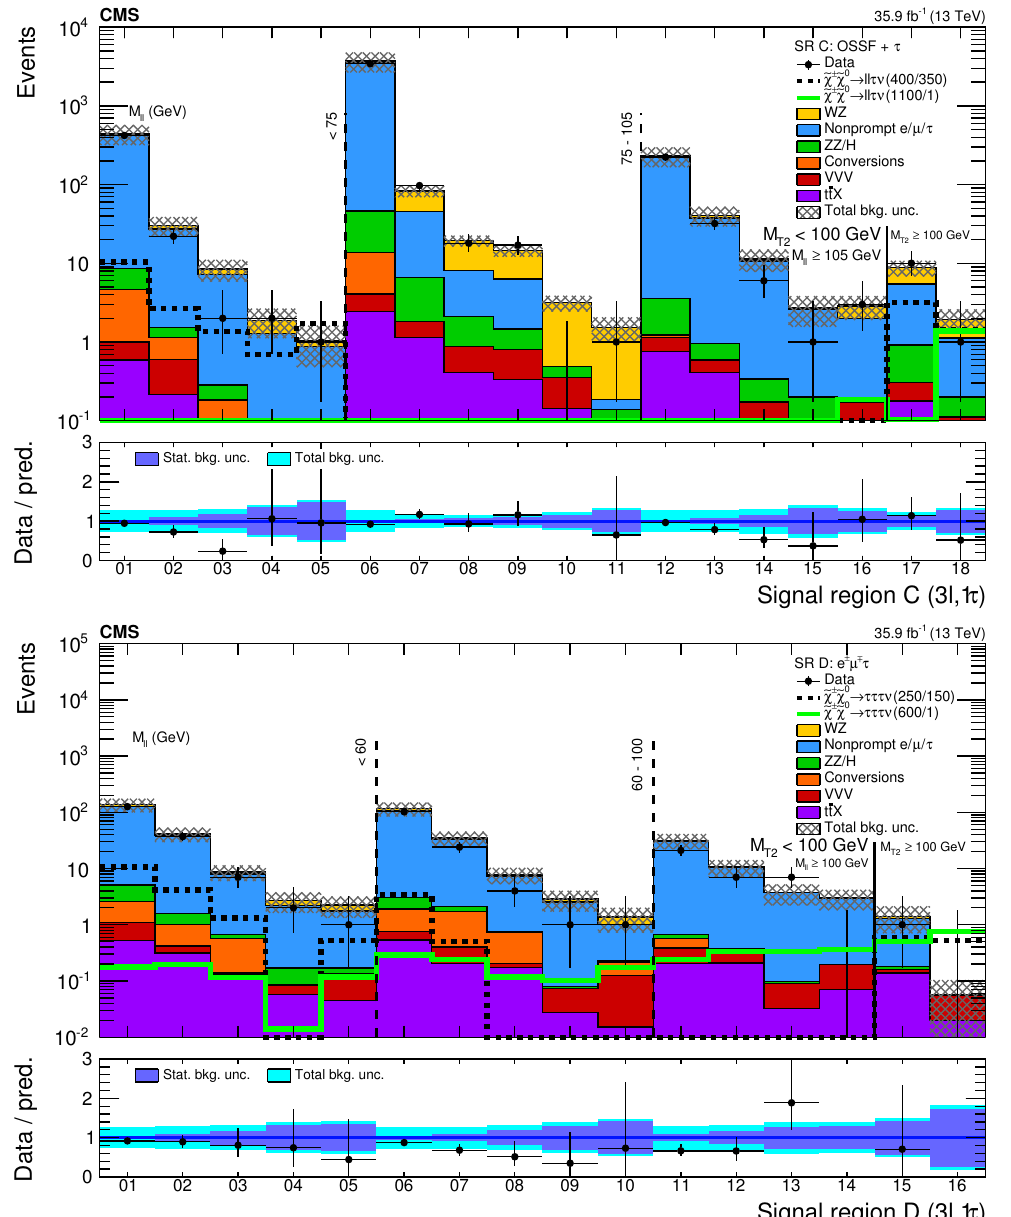
Figure 10 . Expected and observed yields comparison in events with one (cid:28) and D (lower). Two signal mass points in the (cid:28) -enriched (upper) and the (cid:28) -dominated (lower) scenarios with mass parameter x = 0 : 5 are displayed for illustration. The notation is analogous to that used in (cid:12)gure